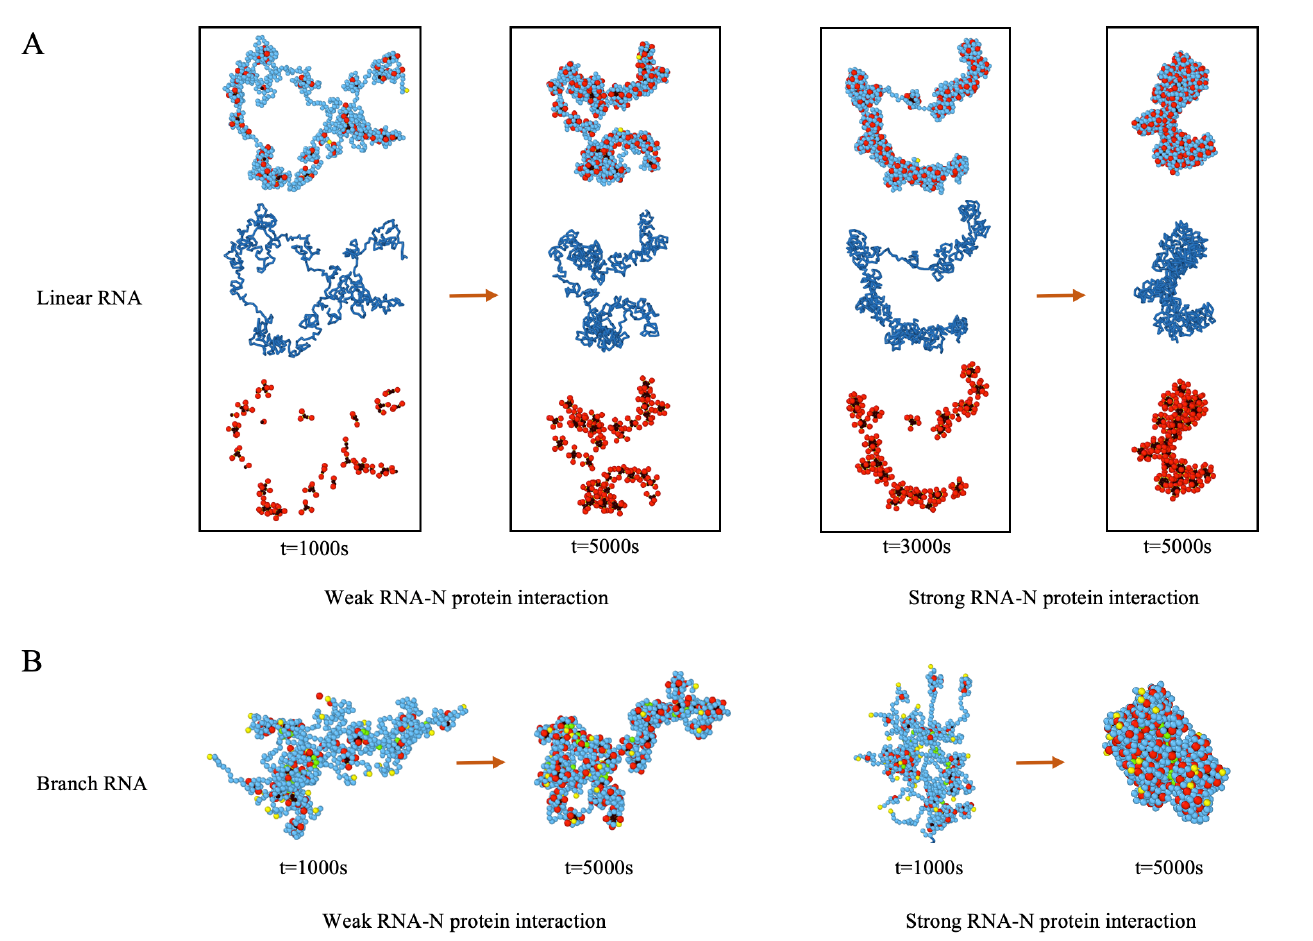
Figure 5. ( A ) N proteins condense a linear chain with L = 800 subunits and form RNP. Both cases of the weak ( Z g = − 2) and strong ( Z g = − 5) RNA–N protein interactions are presented. The N protein concentration is 25µM. In each window, the upper snapshot shows the RNP with genome in blue and N proteins in red and black. The middle and lower snapshots display the RNA and N protein clusters (NPCs), respectively. Note that, if the distance between the N-terminals of N proteins (black) are less than a cut-off distance, they are considered to belong to the same cluster. ( B ) N proteins condense RNA. RNA is modeled as a branched polymer with the branch number N = 30. Both cases of the weak and strong RNA–N protein interactions are considered. The branched points and end points are colored in green and yellow, respectively. At the weak RNA–N protein interaction, the N proteins aggregate into clusters in the same way as they do in the case of linear chains, regardless of the branching structure of the chain. The situation differs for the case of the strong RNA–N